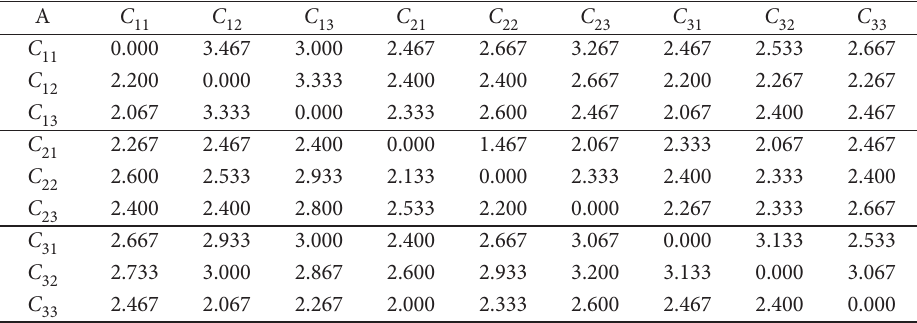
Table 2. Initializing the influence-related matrix A